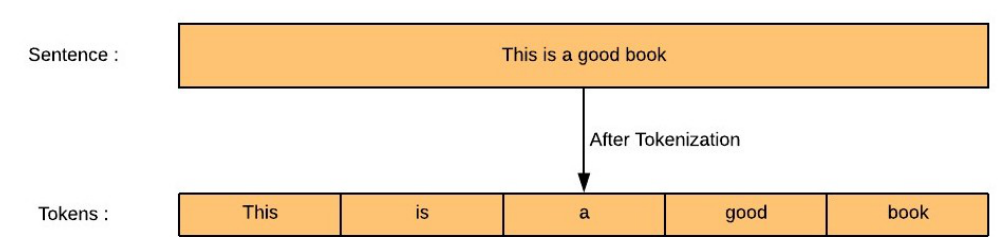
Figure 5. Stopwords Marathi.